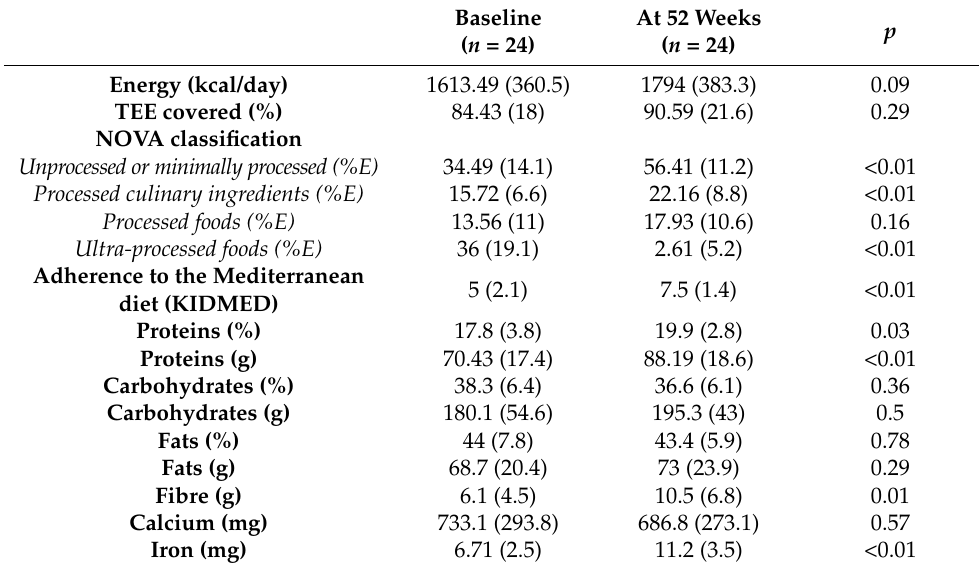
Table 2. Differences in dietary habits upon starting the CDED and at 52 weeks.